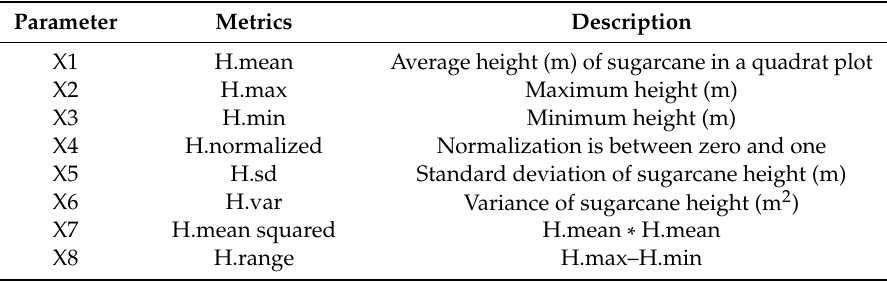
Figure 2. Relationship between sugarcane weight and sugarcane height. The blue solid line represents a linear fit. Weight is positively correlated with height. Table 2. Statistical summary of the characteristics captured from 105 sampling plots.